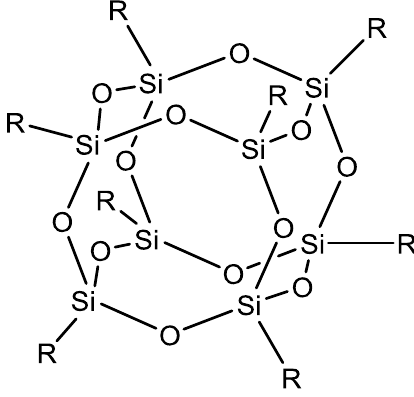
Figure 16. Structure of a typical polyhedral oligomeric silsequioxane.